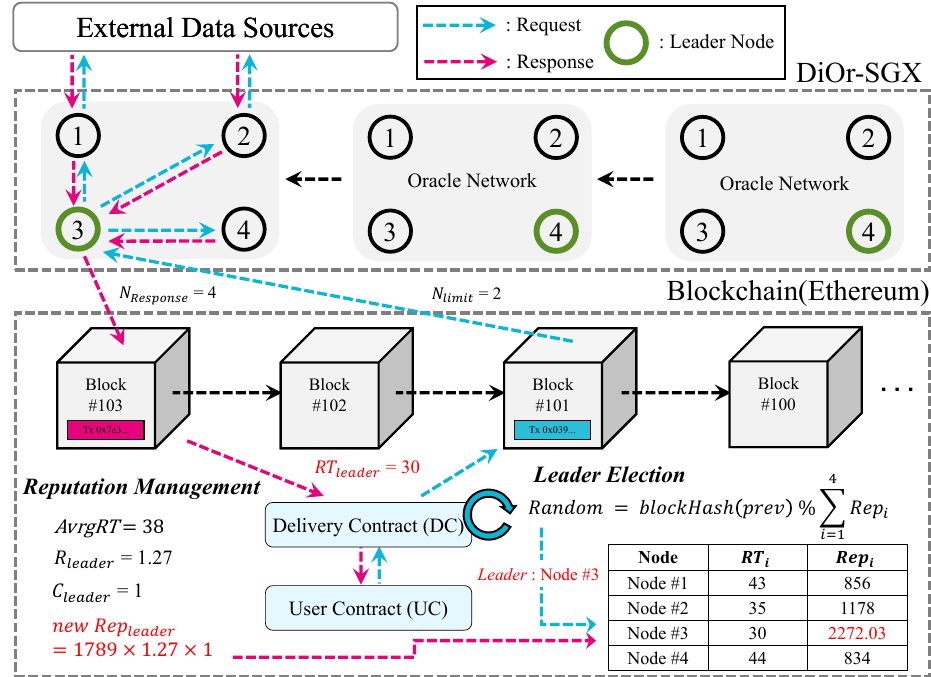
Figure 8. Example of Reputation Management and Leader